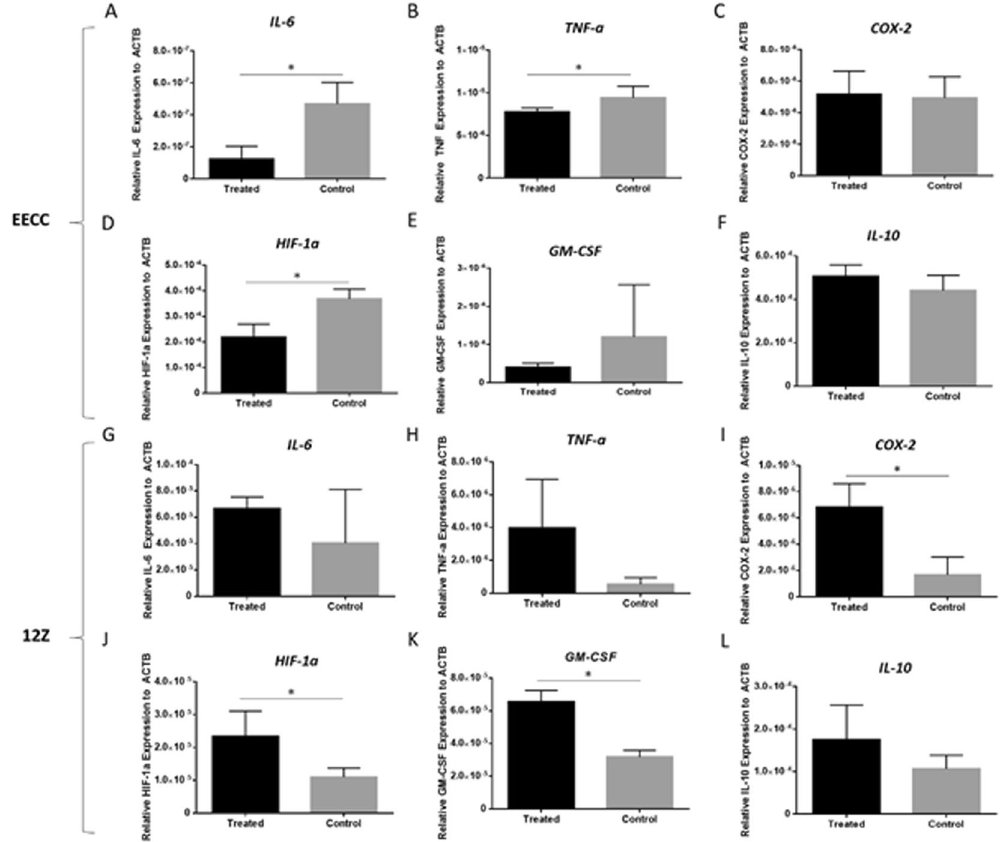
Figure 6. TTP knockdown results in distinct endometriotic (12Z) and endometrial epithelial (EECC)-specific inflammatory profiles: In vitro downstream mRNA analysis of inflammatory cytokines associated with RNA binding protein regulation in TTP knockdown EECCs and 12Zs. Transcripts for IL-6 , TNF- α , HIF-1 α were downregulated in EECC cells treated with TTP siRNA (Panels A,B,D) compared to scrambled controls. Transcripts for COX-2 , GM-CSF , and IL-10 do not differ in TTP knockdown EECCs (Panels C,E,F). On the other hand, TTP knockdown results in upregulation of COX-2 , HIF-1 α and GM-CSF in endometriotic epithelial 12Z cells treated with TTP siRNA compared to scrambled controls (Panels I–K). Transcripts for IL-6 , TNF- α , and IL-10 do not differ in TTP knockdown 12Zs (Panels G,H,L). Expression data illustrated as mean ± SEM. * P < 0.05. Each group (treated and control) consisted of three wells performed in triplicates. Data is derived from three independent experiments; n =